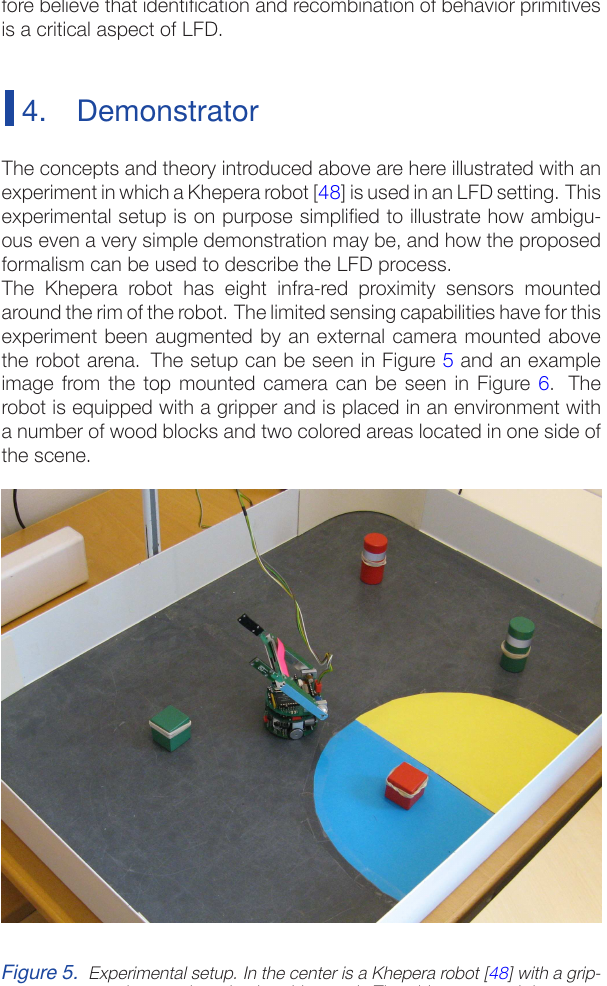
Figure 5. Experimental setup. In the center is a Khepera robot [48] with a grip- per that can be raised and lowered. The objects around the scene are painted wood blocks. Rubber bands have been placed around the objects to facilitate gripping. A camera has been mounted directly above the scene, see Figure 6.